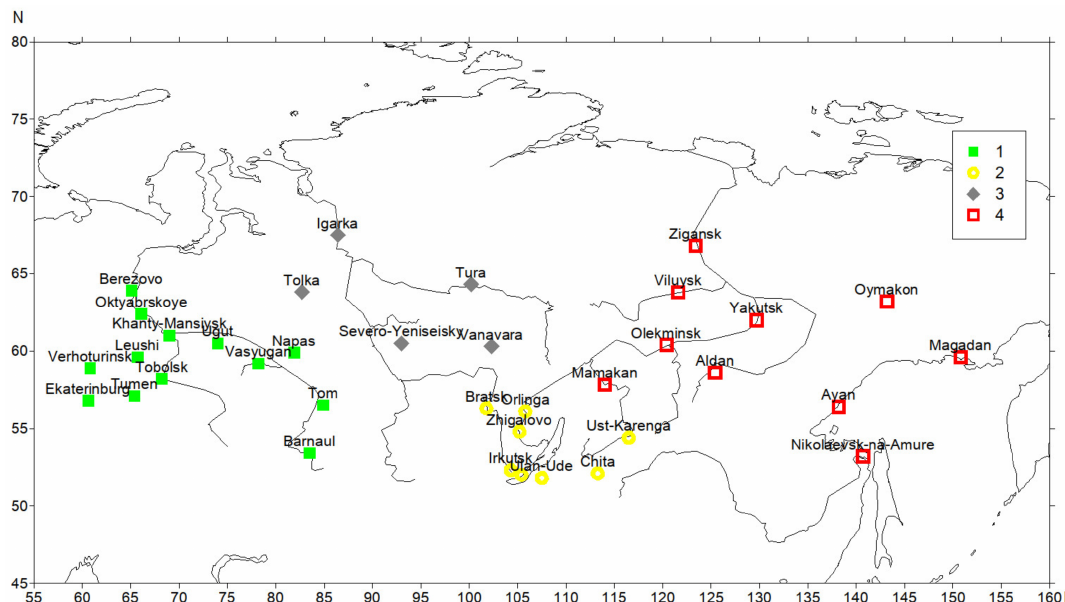
Figure 2. Delimitation of the territory of Siberia into 4 regions (different colours) by interannual variability of potential evapotranspiration, precipitation, and potential evapotranspiration coefficient for